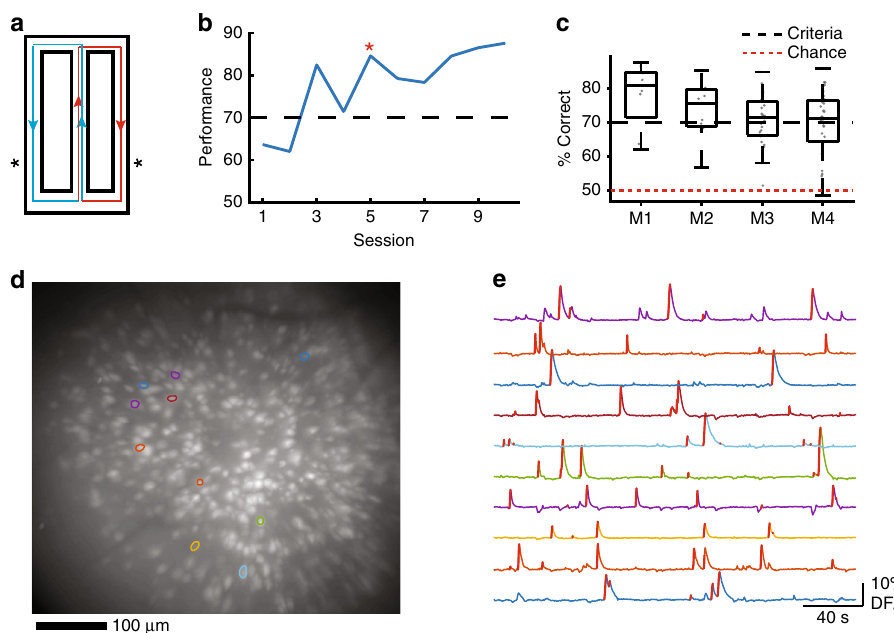
Fig. 1 Experimental setup and imaging. a Alternation Maze. Blue = Left turn trajectories, Red = Right turn trajectories, * = location of food reward. b Example learning curve for one mouse. Black dashed = acquisition criterion (70%), red asterisk = task acquisition day. c Performance summary for all four mice ( n = 10, 10, 23, 28 sessions). Black dashed = criterion, red dashed = chance. Box plots show median and 25th/75th percentiles, whiskers show data extent excluding outliers. d Representative maximum projection from one imaging session (873 neurons detected) with 10 neuron ROIs overlaid. The maximum projection was consistent for each mouse across 10, 7, 23, and 28 sessions with 748 ± 102, 337 ± 46.5, 1030 ± 79.7, and 611 ± 147 neurons detected respectively (mean ± std). e Example calcium traces for ROIs depicted in ( d ). Red lines on the ascending phase of each calcium event indicate inferred spiking